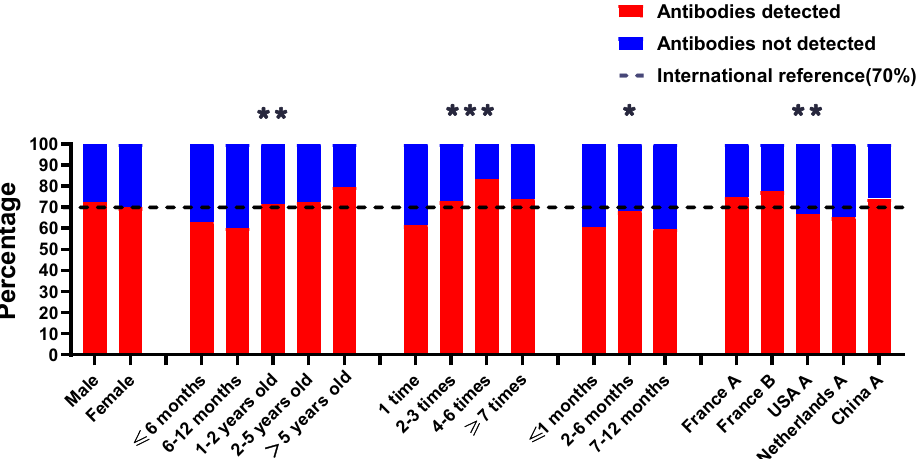
Figure 4. Effect of different factors on the qualification rate of rabies vaccine. Note: * Significant differences exist between variable categories at 5% significant level. ** Significant differences exist between variable categories at 1% significant level. *** Significant differences exist between variable categories at 0.1% significant level.